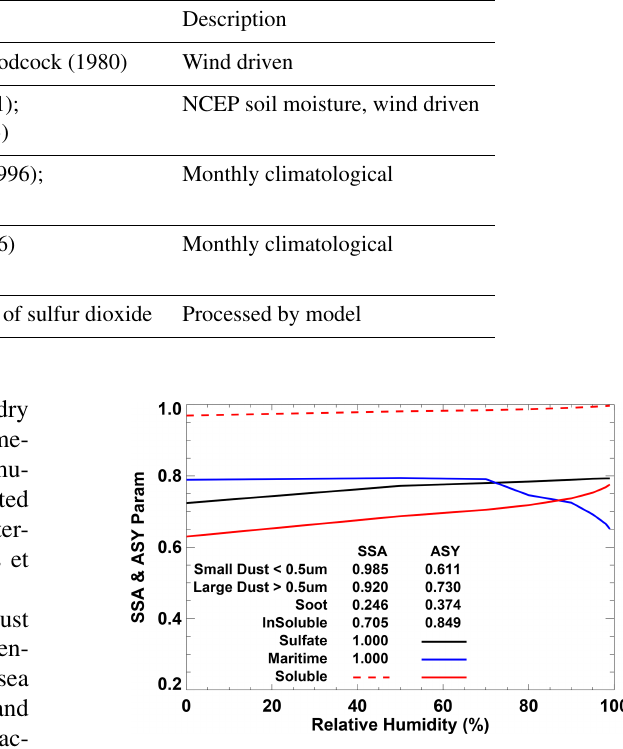
Figure 1. The single-scattering albedo (SSA) and asymmetry pa- rameter (ASY) for the seven aerosol types available in the Langley Fu–Liou model SYN1deg calculations. Only those that vary with relative humidity are plotted; others are listed as constants. All val- ues are for properties at 550µm. (Dust particle size refers to r eff